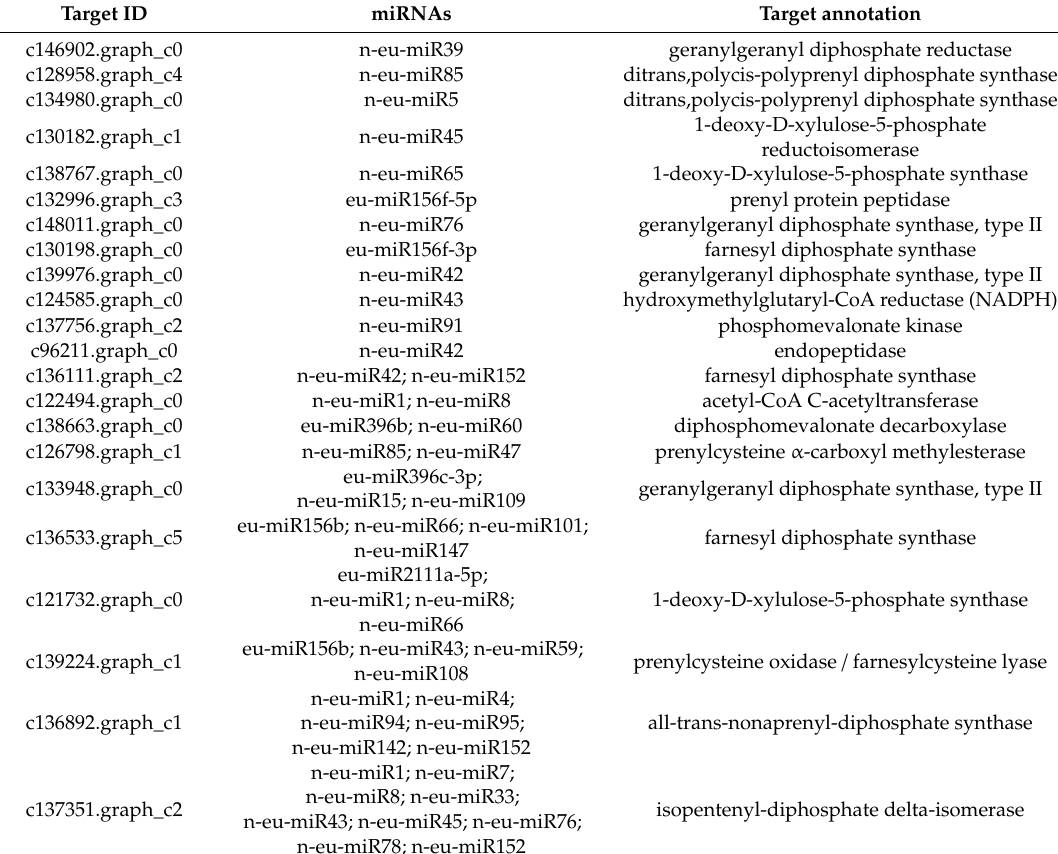
Table 1. The targets of known and novel miRNAs involved in terpenoid backbone